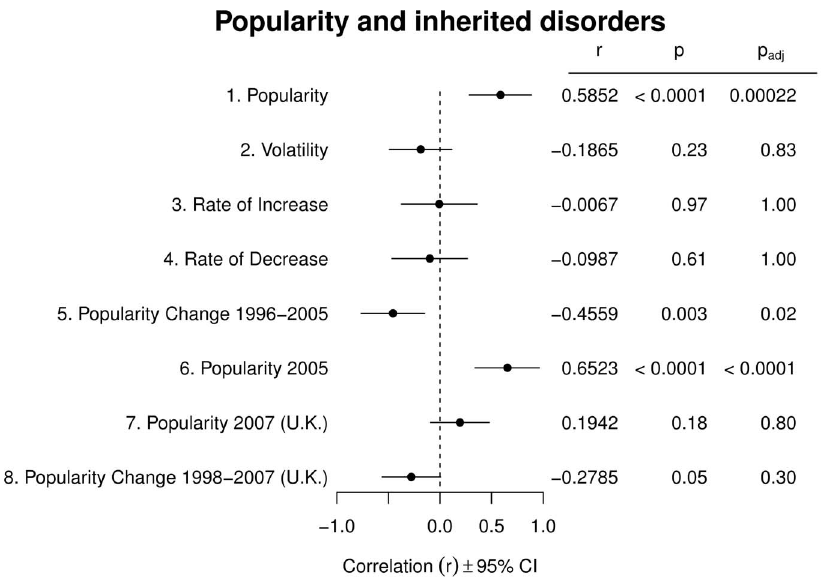
Figure 3. Inherited deseases and breed popularity. Pearson’s correlations between number of inherited diseases per breed and indicators of breed popularity in the U.S. and U.K. See legend to Figure 2 for details of the display. Sample sizes for rows 1–8 are, respectively: N ~ f 43,43,29,29,41,41,48,48 g :